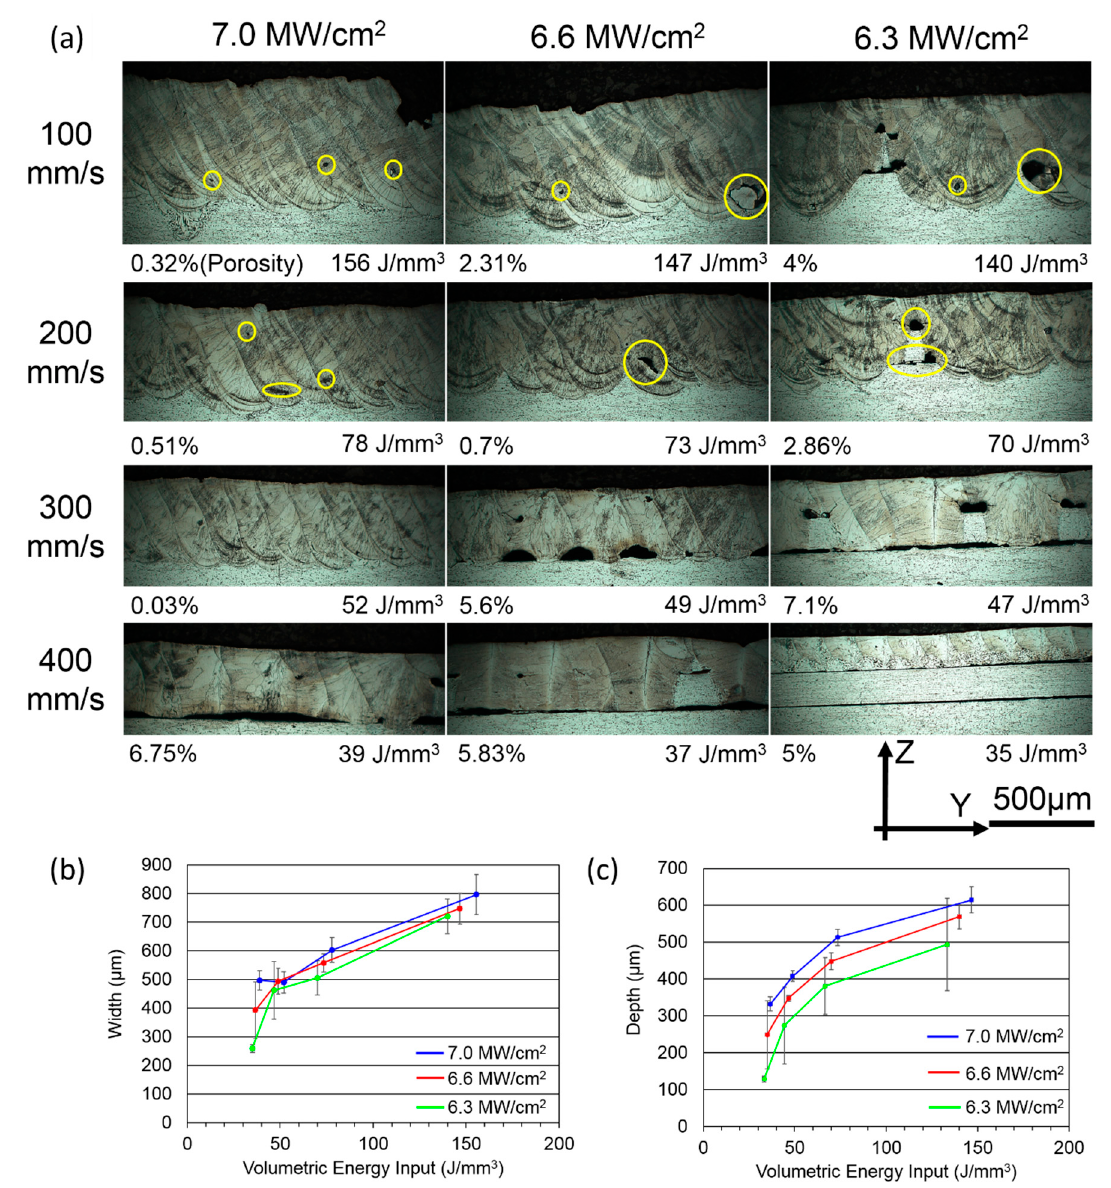
Figure 4. ( a ) Cross-sectioned OM images in Y-Z plane at different levels of power density (MW/cm 2 ), volumetric energy input (J/mm 3 ), and scanning speed (mm/s); the porosity of each image is given at its bottom left; ( b ) width of melt pool; and ( c ) depth of melt pool vs. VEI at the different levels of power density: 6.3 MW/cm 2 (Green), 6.6 MW/cm 2 (red), and 7.0 MW/cm 2 (blue).